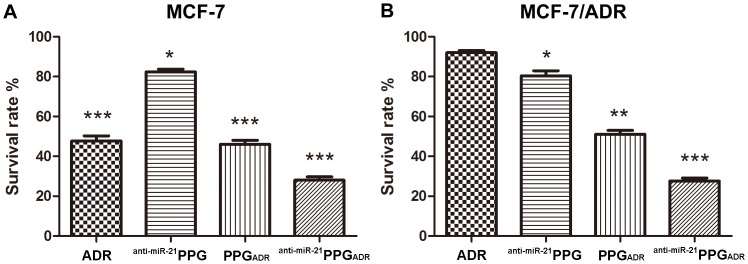

In vitro cellular cytotoxicity.Relative survival rate of MCF-7 cells (A) and MCF-7/ADR cells (B) after being treated with ADR, anti-miR-21PPG, PPGADR and anti-miR-21PPGADR for 24 h. Untreated MCF-7 and MCF-7/ADR cells were served as control in each experiment. Data are means ± SD for three separate experiments, *P<0.05, **P<0.01, ***P<0.001.